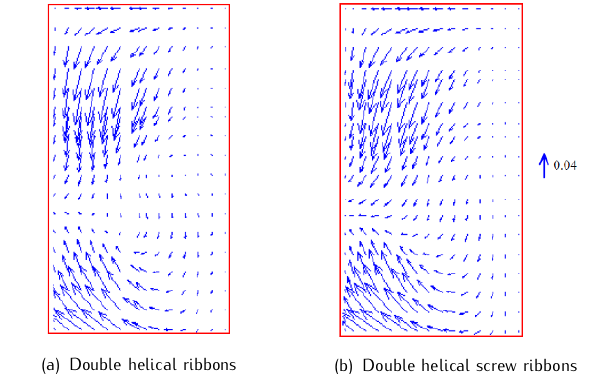
Figure 4. Flows patterns induced in r-z plane defined by